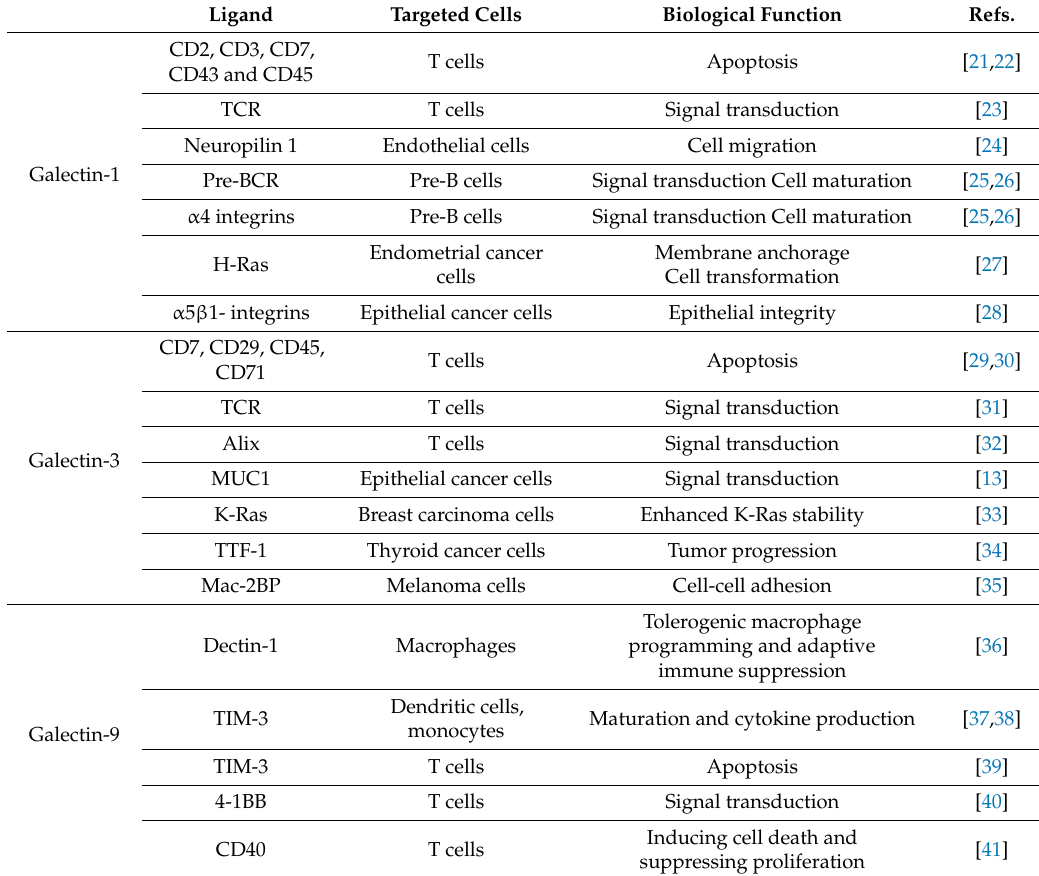
Table 1. Galectin-1, -3, -9 and their binding partners in the regulation of immune responses and tumor